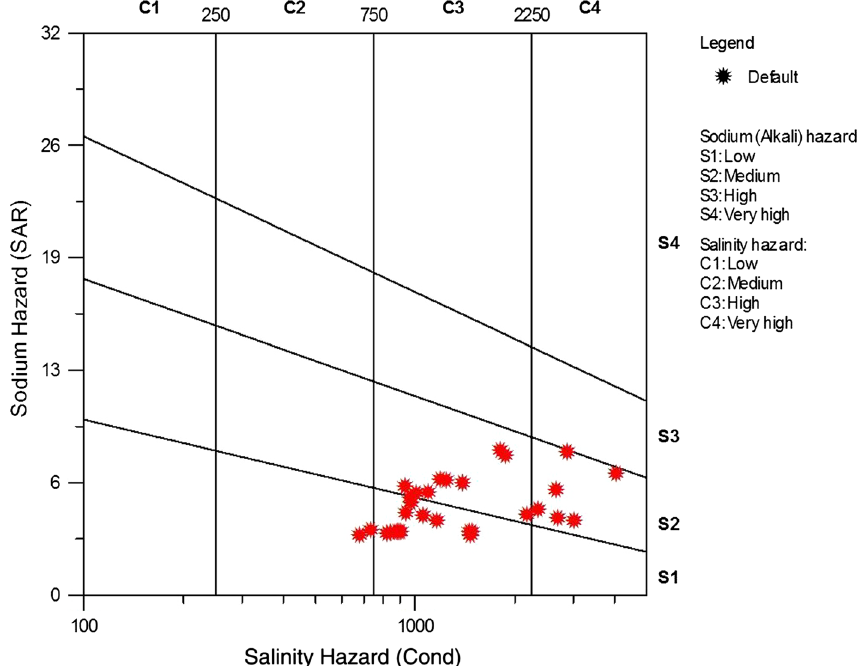
Fig. 17 US salinity diagram for classification of irrigation waters (after Richards 1954), samples from the Mothkur region, Telangana State,